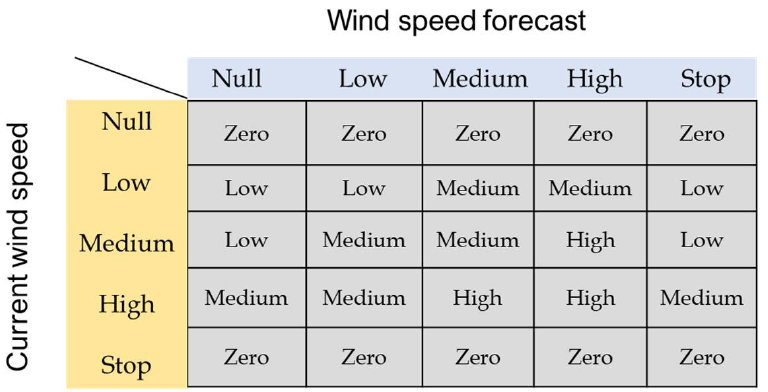
Figure 4. Inference rules of the wind fuzzy system (Stage 2).